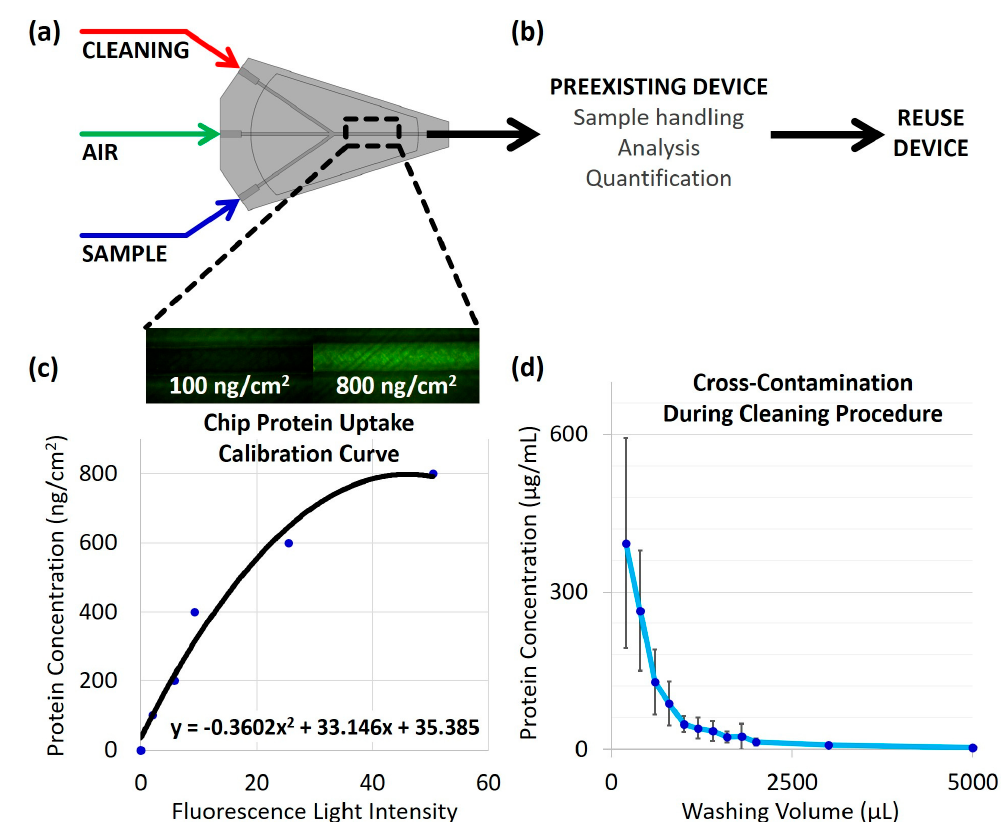
Figure 1. Design, core functionality, and experimental overview: ( a ) Generalized design of cleaning chip. The cleaning chip device consists of inlets for the sample, cleaning solution, and air, all connected to a single outlet. This design allows for a cleaning procedure to be performed on the chip itself and any external microfluidic device that is connected to the cleaning chip’s outlet; ( b ) Core functionality of the cleaning chip. The cleaning chip may be used in conjunction with a pre-existing microfluidic device, which may itself perform sample handling, analysis, quantification, etc., in order to render the external device a reusability microfluidic device by connecting the outlet of the cleaning chip to the inlet of the pre-existing device; ( c ) Experimental preview of chip protein uptake. The 3D-printed cleaning chip was connected to a syringe pump, and the cleaning solution was collected from the outlet of the cleaning chip for protein cross-contamination quantification, while the chip itself was assessed for protein absorption. A fluorescence detection method was used to determine the concentration of protein present in the collected samples from the outlet and within the chip itself; the CBQCA assay used fluoresces green by excitation with blue light. Above, the two images shown provide an example of the fluorescent images with their respective protein concentrations. Below, the calibration curve used for determining protein uptake by the chip was constructed by injecting known concentrations of protein into channels of a chip and imaging the channels using a fluorescence microscope, where the raw light intensity (on a scale from 0 to 255) was used as the independent variable; ( d ) Experimental preview of cross-contamination results. Collected samples were quantified by using a plate reader to measure the fluorescence of the cleaning solution from the outlet. The observed trend showed the decreasing protein concentration with the increasing washing volume.